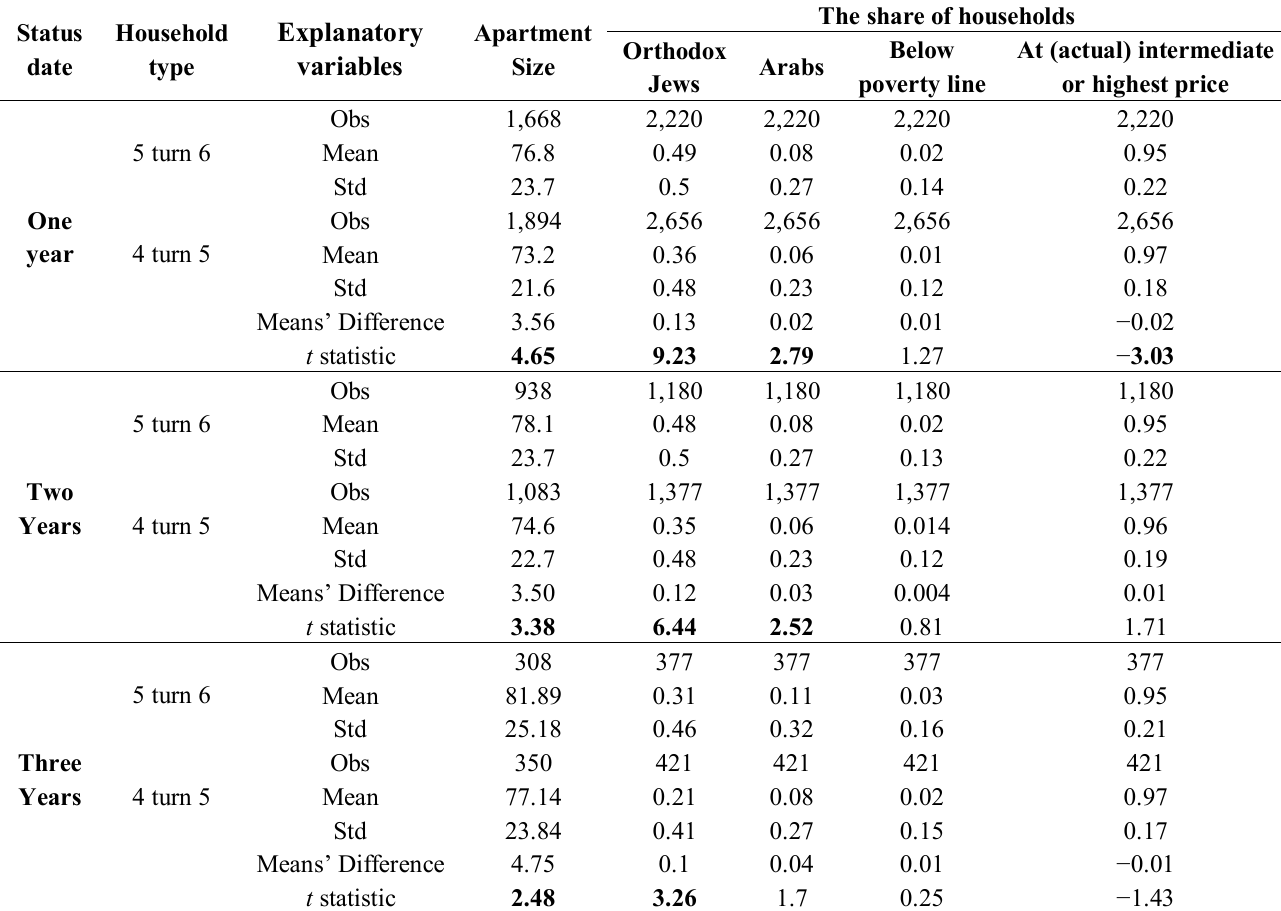
Table 8. Descriptive statistics—a comparison of previously-entitled and control groups